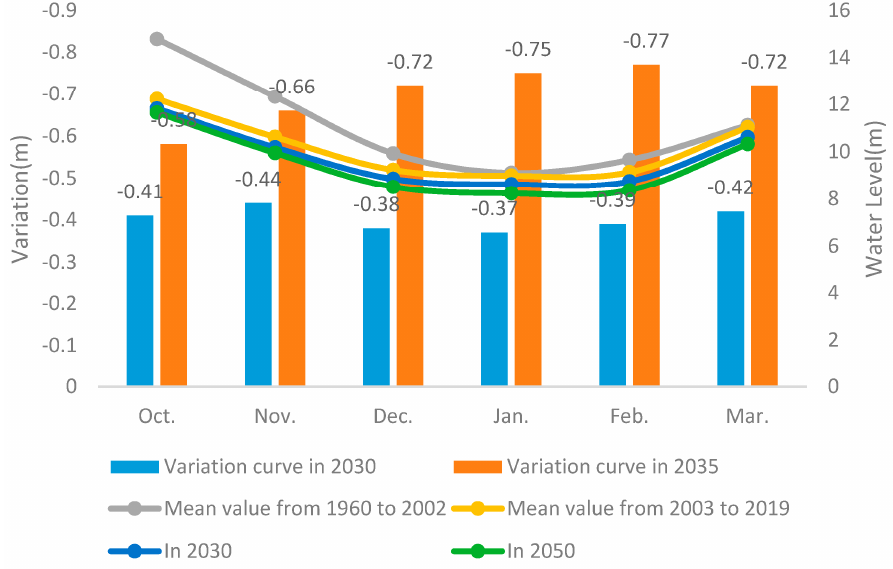
Figure 14. Analysis of the monthly variation curve of the average water level at the Xingzi hydrometric station during the dry season (unit: m).